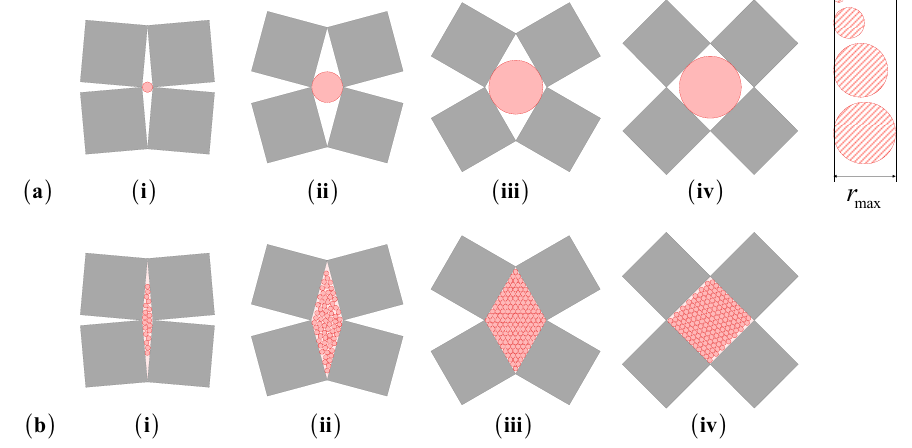
Figure 3. Comparison of different particles sizes as a rotating rigid unit system is stretched (i to iv), illustrating the notion of ( a ) pore size and ( b ) space coverage.